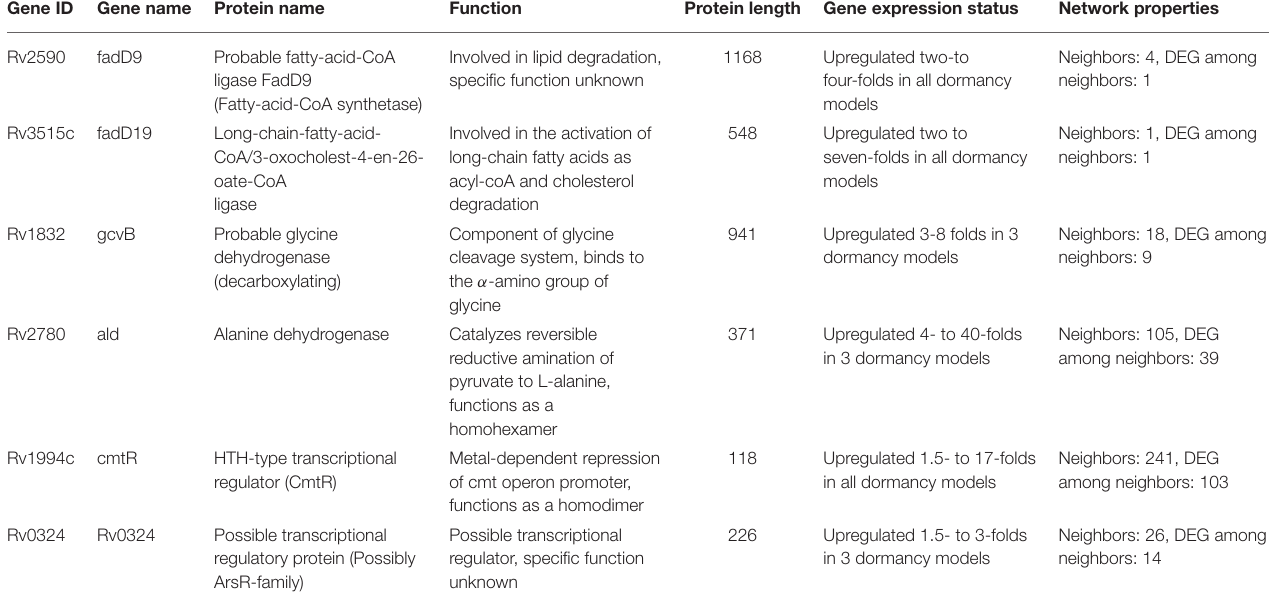
TABLE 3 | Summarized details of the final shortlisted drug target candidates for dormant Mtb